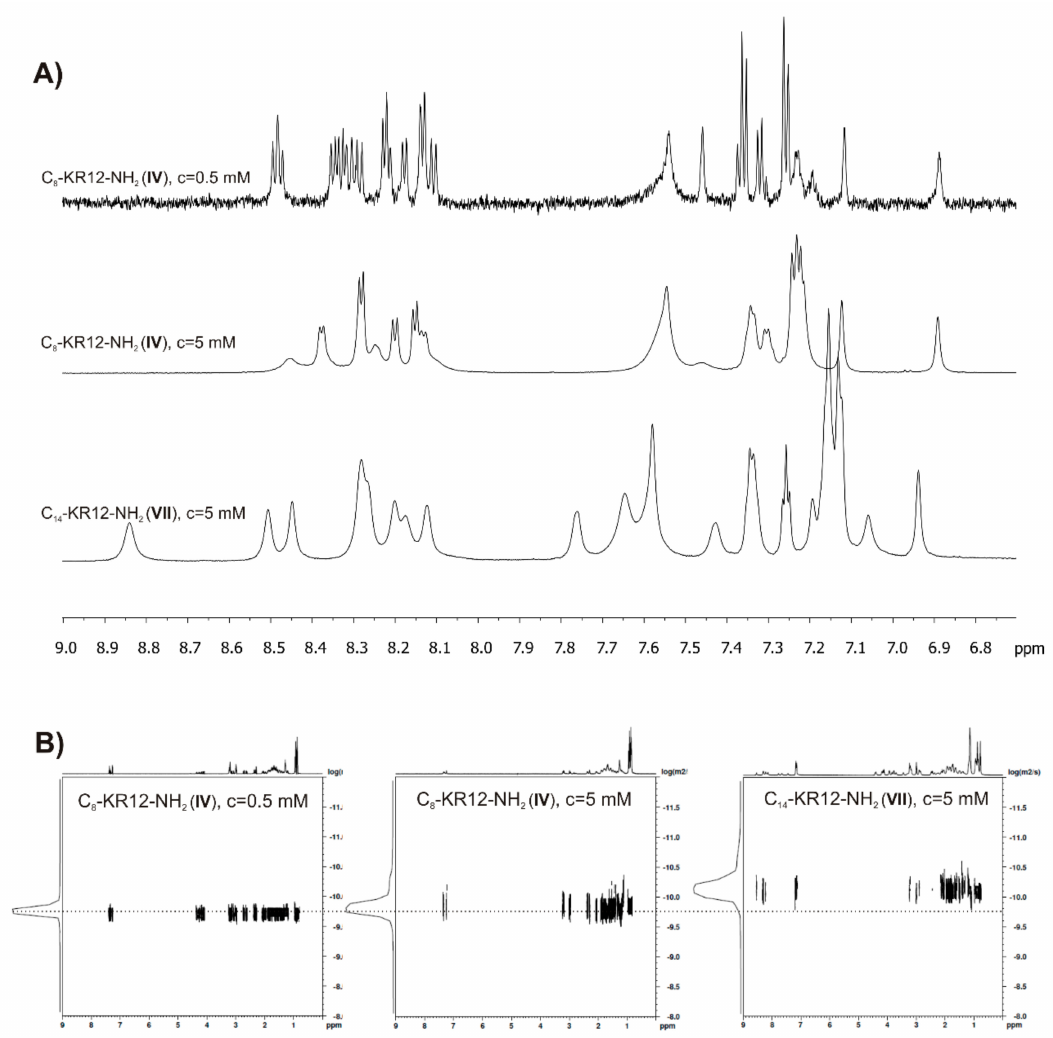
Figure 8. 1 H NMR ( A ) and DOSY ( B ) spectra for C 8 -KR12-NH 2 and C 14 -KR12-NH 2 recorded at concentrations below and / or above critical aggregation concentration